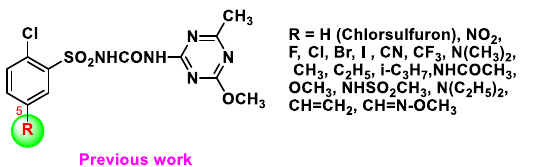
Figure 1. The 5th substituted groups on the benzene ring in chlorsulfuron.